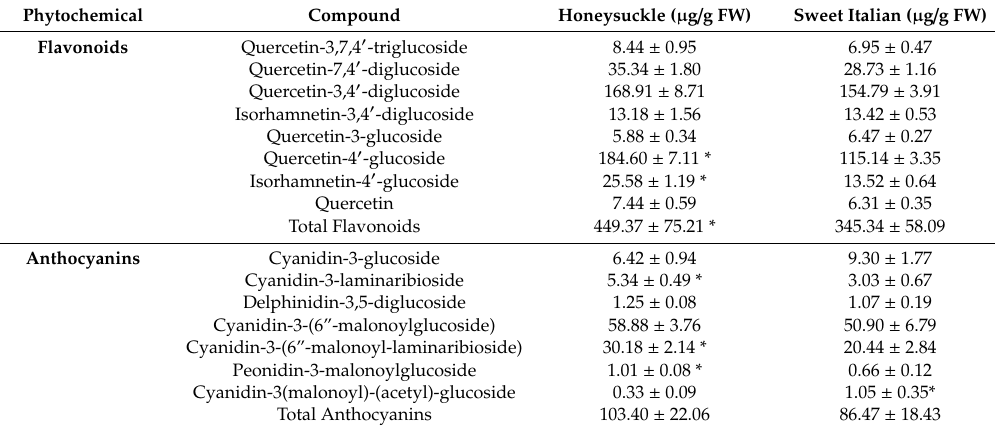
Table 3. Quantification of flavonoids and anthocyanins in red onions by HPLC.